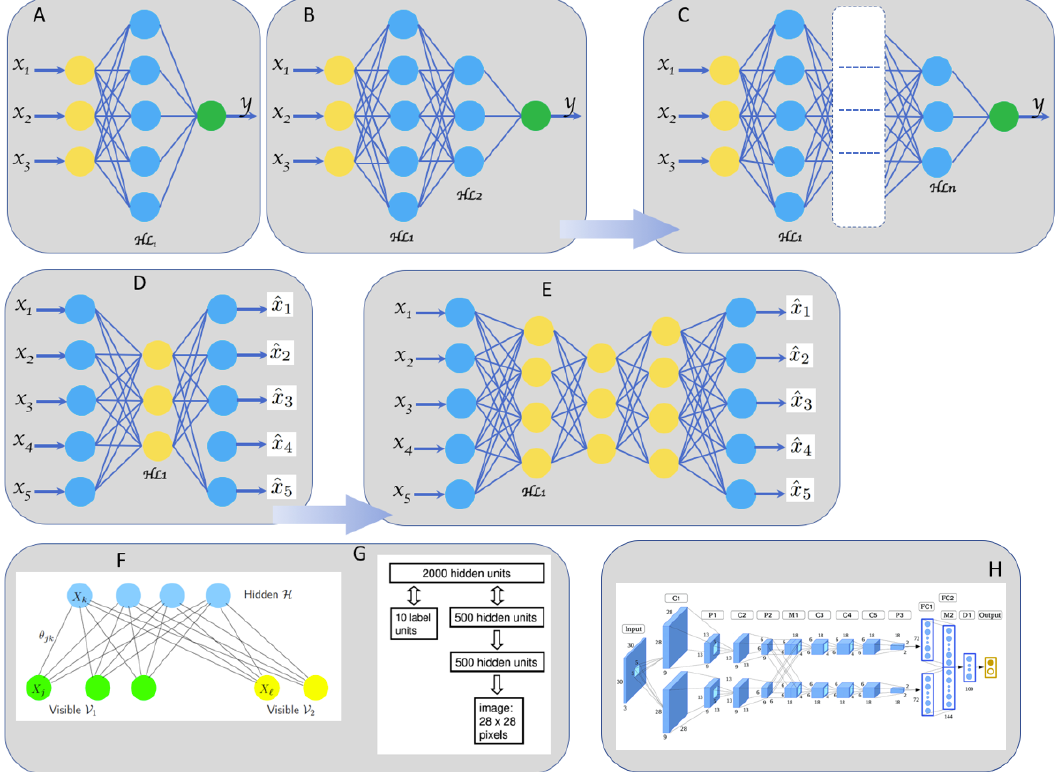
Figure 7. Most popular Neural Networks architectures used in biomedical: ( A – C ) feedforward neural networks with several depths (one hidden layer, two hidden layers and a deep architecture with many hidden layers); ( D , E ) an Auto-Encoder and a Deep Auto-Encoder, respectively; ( F , G ) representations of a restricted Boltzmann machine and a deep belief networks, respectively; and ( H ) an AlexNet [42] convolutional neural